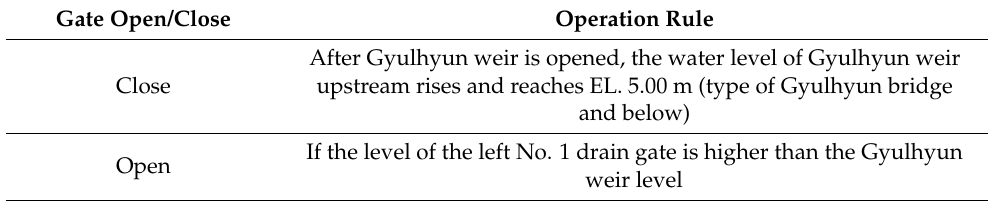
Table 10. Left No. 1 Drainage Gate Operation Rule.